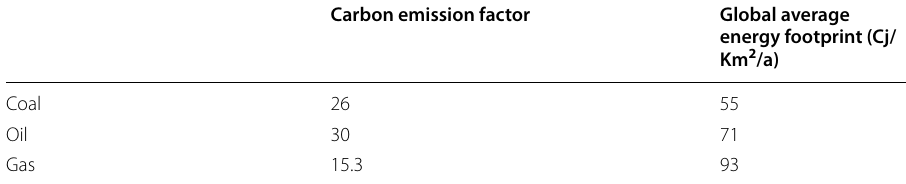
Table 2 Global average energy